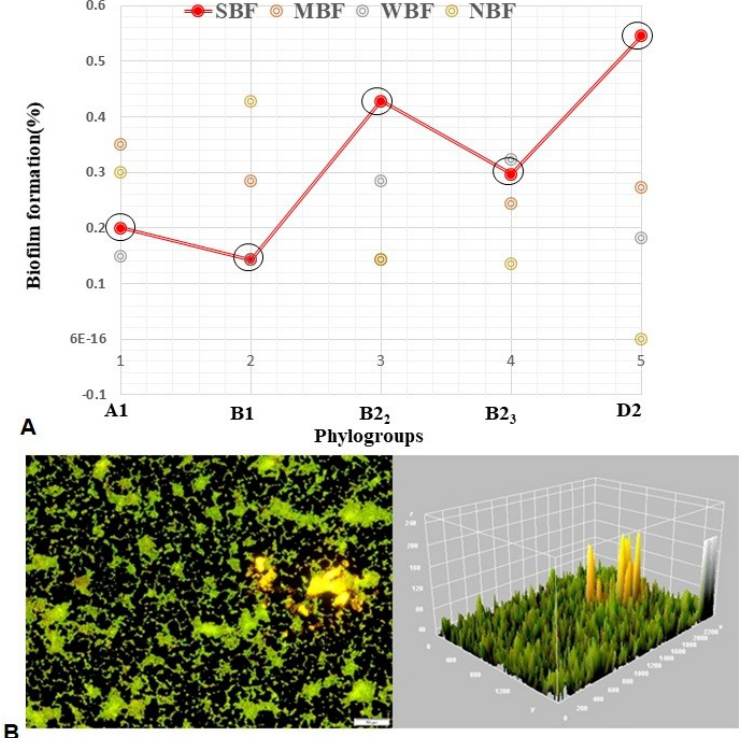
Figure 4. Biofilm formation (BF) ability of the APEC phylogroups. ( A ) Diagrammatic representation of BF in various phylotypes. Here: SBF, strong biofilm formers; MBF, moderate biofilm formers; WBF, weak biofilm formers; NBF, non-biofilm formers. Red solid line with black circle represented the SBF ability fluctuations in which the isolates of phylogroup B1 had the lowest (14%) BF ability, and the phylogroup D2 isolates showed the highest (54.55%) BF ability. ( B ) Fluorescence microscopy images of isolate (RN3, D2) under 20 × magnification. Biofilm stained with film tracer LIVE / DEAD biofilm viability kit. Live or active cells are fluorescent green and dead or inactive cells are fluorescent red. Surface plot of 3D volume image (center image) and cross section of 3D volume image (right side image) show the distribution of live and dead cells throughout biofilm layers.